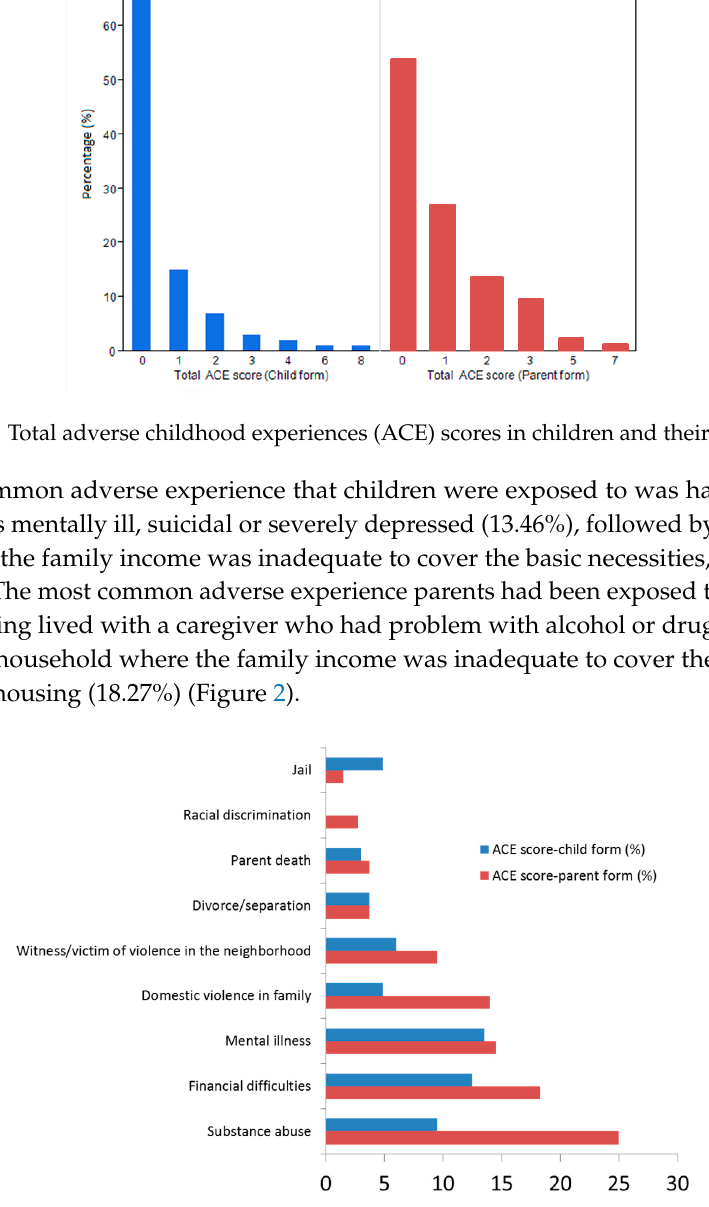
Figure 2. Distribution of the various childhood events.